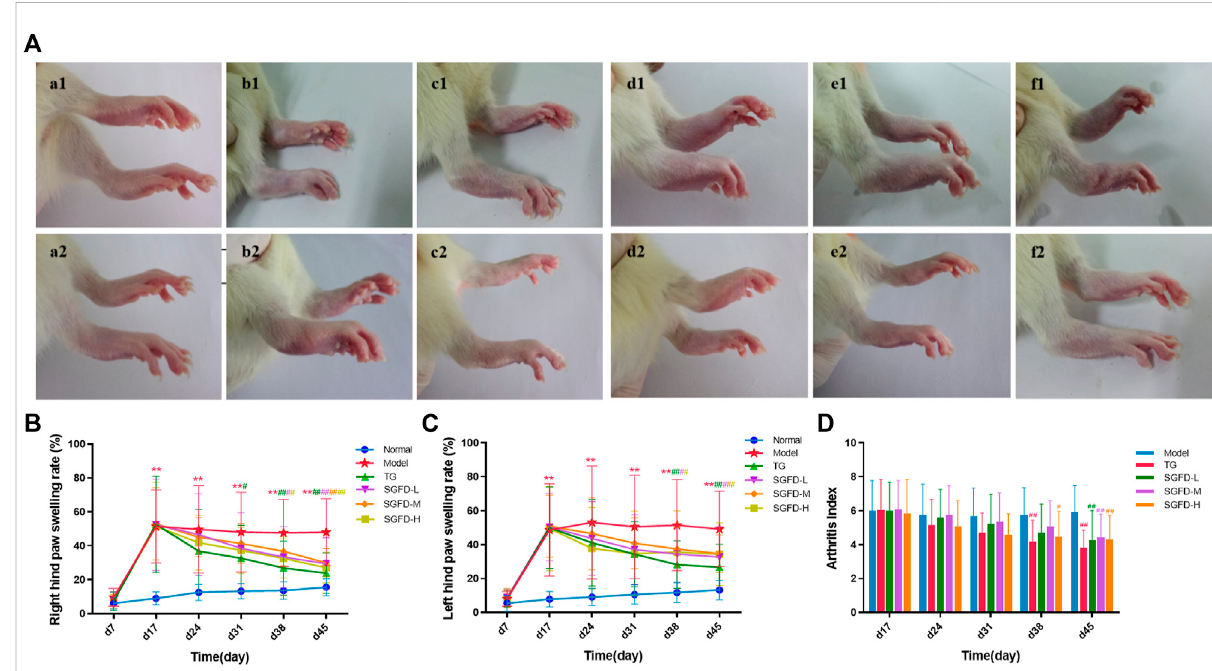
FIGURE 3 Effect of SGFD on joint swelling in RA rats. (A) . Images of rats ’ paw swelling in each group (a1-f1: before treatment; a2-f2: after treatment). (B) . The results of right hind paw swelling rate. (C) . The results of left hind paw swelling rate. (D) . The results of AI scores. Data were shown as mean ± SD (Normal, n = 13; Model,TG, SGFD-L, SGFD-M, n = 12; SGFD-H, n = 10). * p < 0.05, ** p < 0.01 vs. normal group; # p < 0.05, ## p < 0.01 vs.model